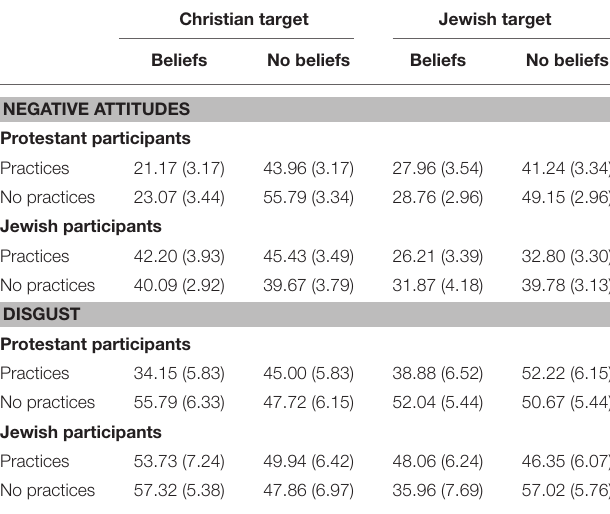
TABLE 5 | Negative attitudes and disgust toward target individual (Study 3).